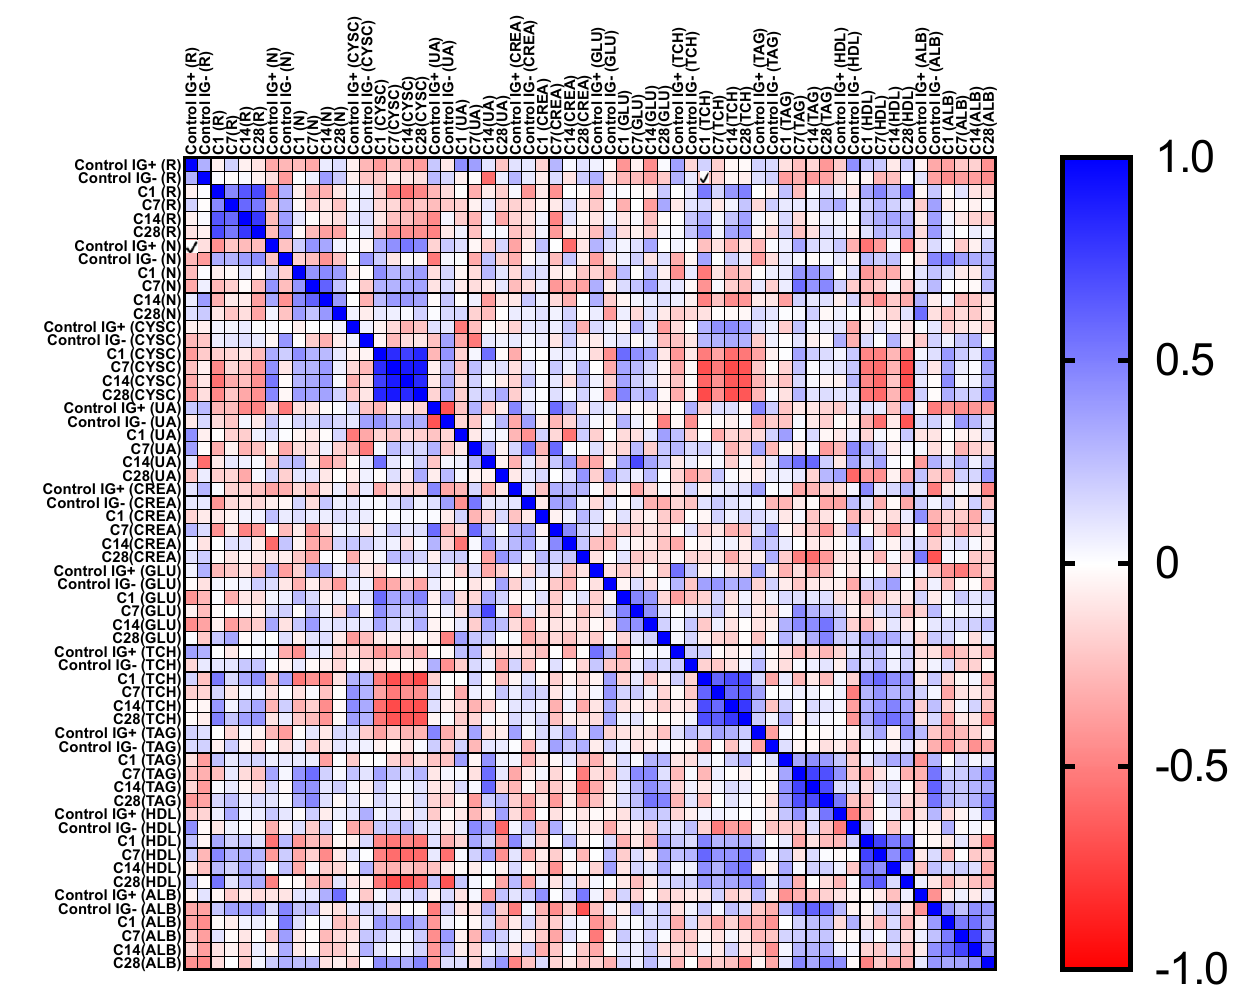
Figure 3. Correlation matrix heatmap for analyzed parameters in all groups; R—renalase; N— neutrophil gelatinase-associated lipocalin (NGAL); CYSC—cystatin C; UA—uric acid; CREA— creatinine; GLU—glucose; TCH—total cholesterol; TAG—triglycerides; HDL—high-density lipoprotein cholesterol; ALB—albumin. An interesting observation was a significant, moderate negative correlation be- tween cystatin C and total cholesterol in each of the time-points in the COVID-19